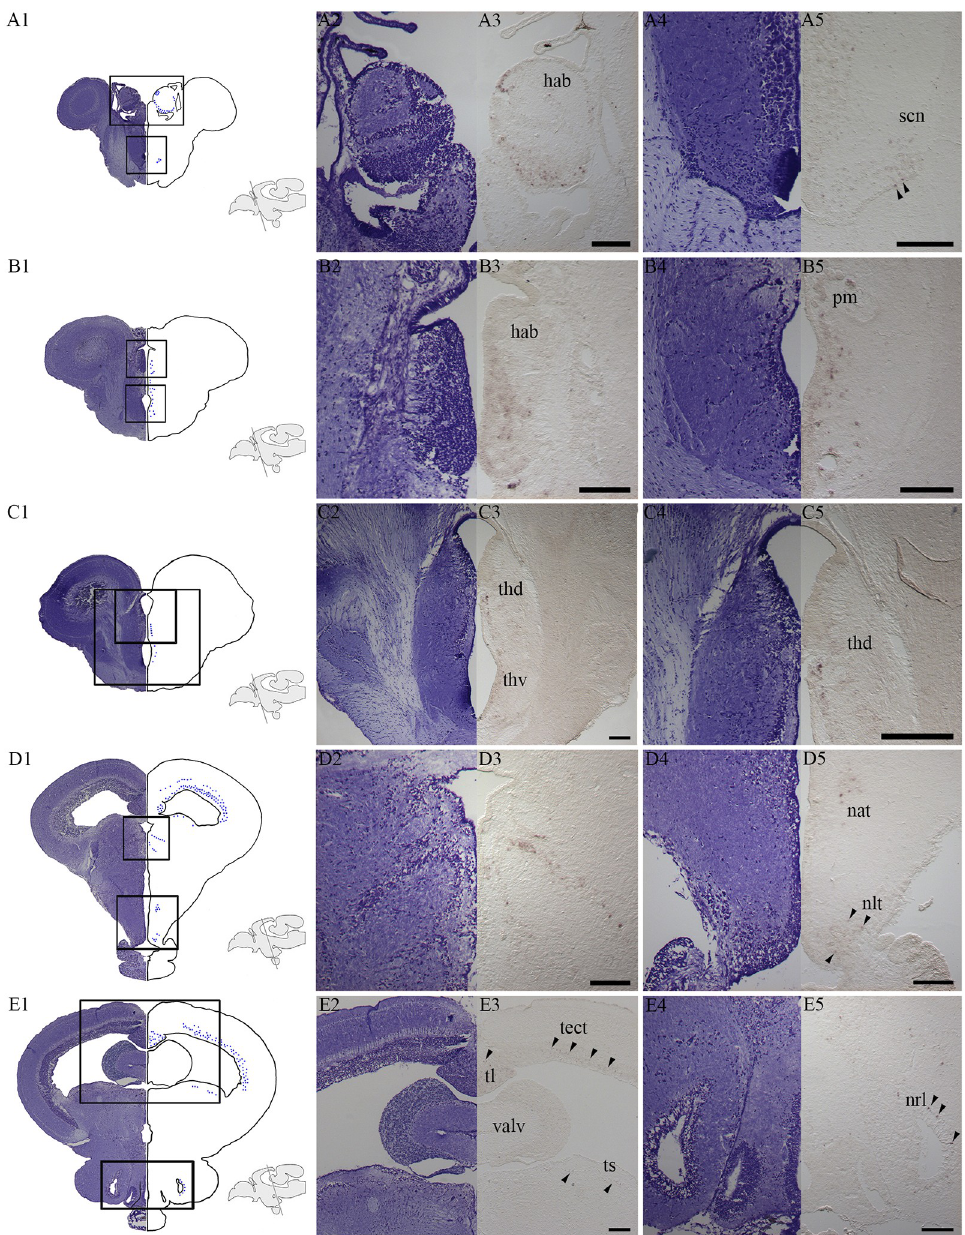
Fig 3. Activated brain regions after stimulation with white light for 120 minutes. A1-E1: Nissl-stained transverse sections at the equivalent level of c-fos expressing cells illustrated by blue dots in salmon, parr. Schematic drawings illustrate the level of the section. A2-E2, A4-E4: The Nissl-stained cell populations of interest with a higher magnification. A3-E3, A5-E5 : c-fos expression at the same level and with the same high magnification. The overview illustrations (A1-E1) and the left sided tissues with c-fos expression (A3-E3, A5-E5) are presented by flipping the pictures, resembling a whole brain section. A3 : Expression in a dorsal ring in the left habenula (hab) and in ventral parts of the habenula. A5: c-fos expression in the suprachiasmatic nucleus (scn). B3: A cell group expressing c-fos just ventral to the caudal habenula. B5 : Expression in cells close to the third ventricle and in the magnocellular preoptic nucleus (pm). C3: Activated cells in the dorsal thalamus (thd) and ventral thalamus (thv) (posterior nucleus of thalamus) close to the third ventricle. C5 : Focus on the expression in dorsal thalamus (thd) where the expression was strongest. D3: Expression of c- fos in caudal parts of the thalamus. D5: In the hypothalamus, expression was seen in the anterior tuberal nucleus (nat) and lateral tuberal nucleus (nlt). E3: Cells expressing c-fos were also localized in the mesencephalic tectum (tect), longitudinal torus (tl) and semicircular torus (ts). E5: Expression in the nucleus of the lateral recess (nrl). Arrowheads indicate positive cells. Scale bars of 200 μ m.